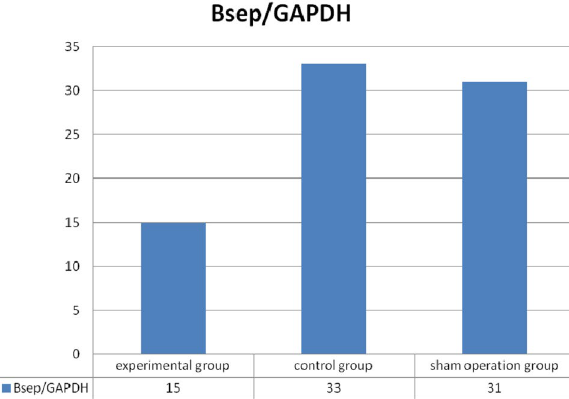
Figure 2. Analysis of Bsep mRNA expression. Through RT-PCR we found that in cancerous, control group and sham operation group the Bsep / GAPDH ratios were 15, 33 and 31, respectively, after eight cycles, and the difference between experimental group and control group was statistically significant ( t = 2.821, P < 0.05), the difference between experimental group and sham operation group was also statistically significant ( t = 2.793, P < 0.05). (SPSS22.0 http://www.downx ia.com/downi nfo/16552